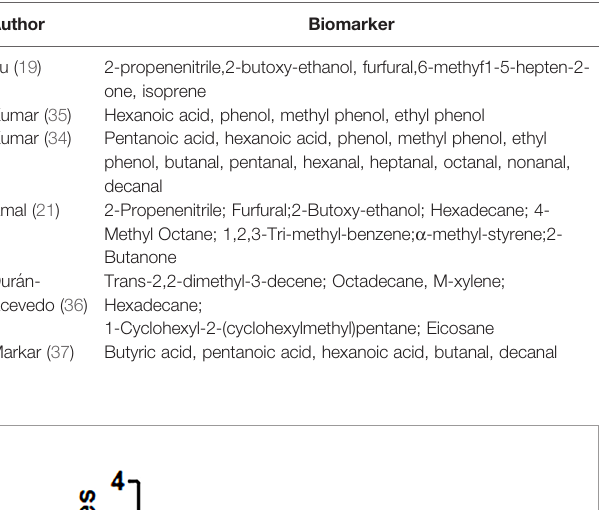
TABLE 4 | Expiratory biomarkers between GEC patients andnon-cancer patients.